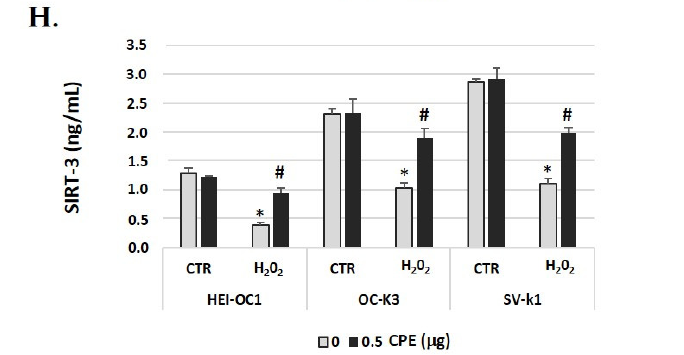
Figure 5. Cocoa increase expression of SIRT-3 in senescence cells. Illustrative fluorescence images of immunostaining of SIRT-3 in ( A ) HEI-OC1, ( C ) OC-k3, and ( E ) SV-k1 cells post-treatments. Nu- clei were detected in blue fluorescence by DAPI, and SIRT-3 immunoreactivity was labeled in red fluorescence; ( B , D , F ) Graphs represent the immunofluorescence intensity analyzed by Image J of ( B ) HEI-OC1; ( D ) OC-k3 and ( F ) SV-k1 cells; ( G ) Gene expression of SIRT-3 in auditory cells cultures post-treatments. ( H ) SIRT-3 protein levels were determined by ELISA assay in auditory cells lysates post-treatments. Experimental groups: CTR group (0 and 5 µ g/mL of CPE for 20 h) and H 2 O 2 group (CPE pre-treatment at 0 and 5 µ g/mL for 20 h and H 2 O 2 post-treatment at 100 µ M for 1 h). Data are means ± SD of Arbitrary Units (AU) ( B , D , F ) and fold change ( G ) (n = 4). * p < 0.05 vs. of CTR group (0 µ g of CPE); # p < 0.05 vs. H 2 O 2 group (0 µ g of CPE). Reference genes: GAPDH and β